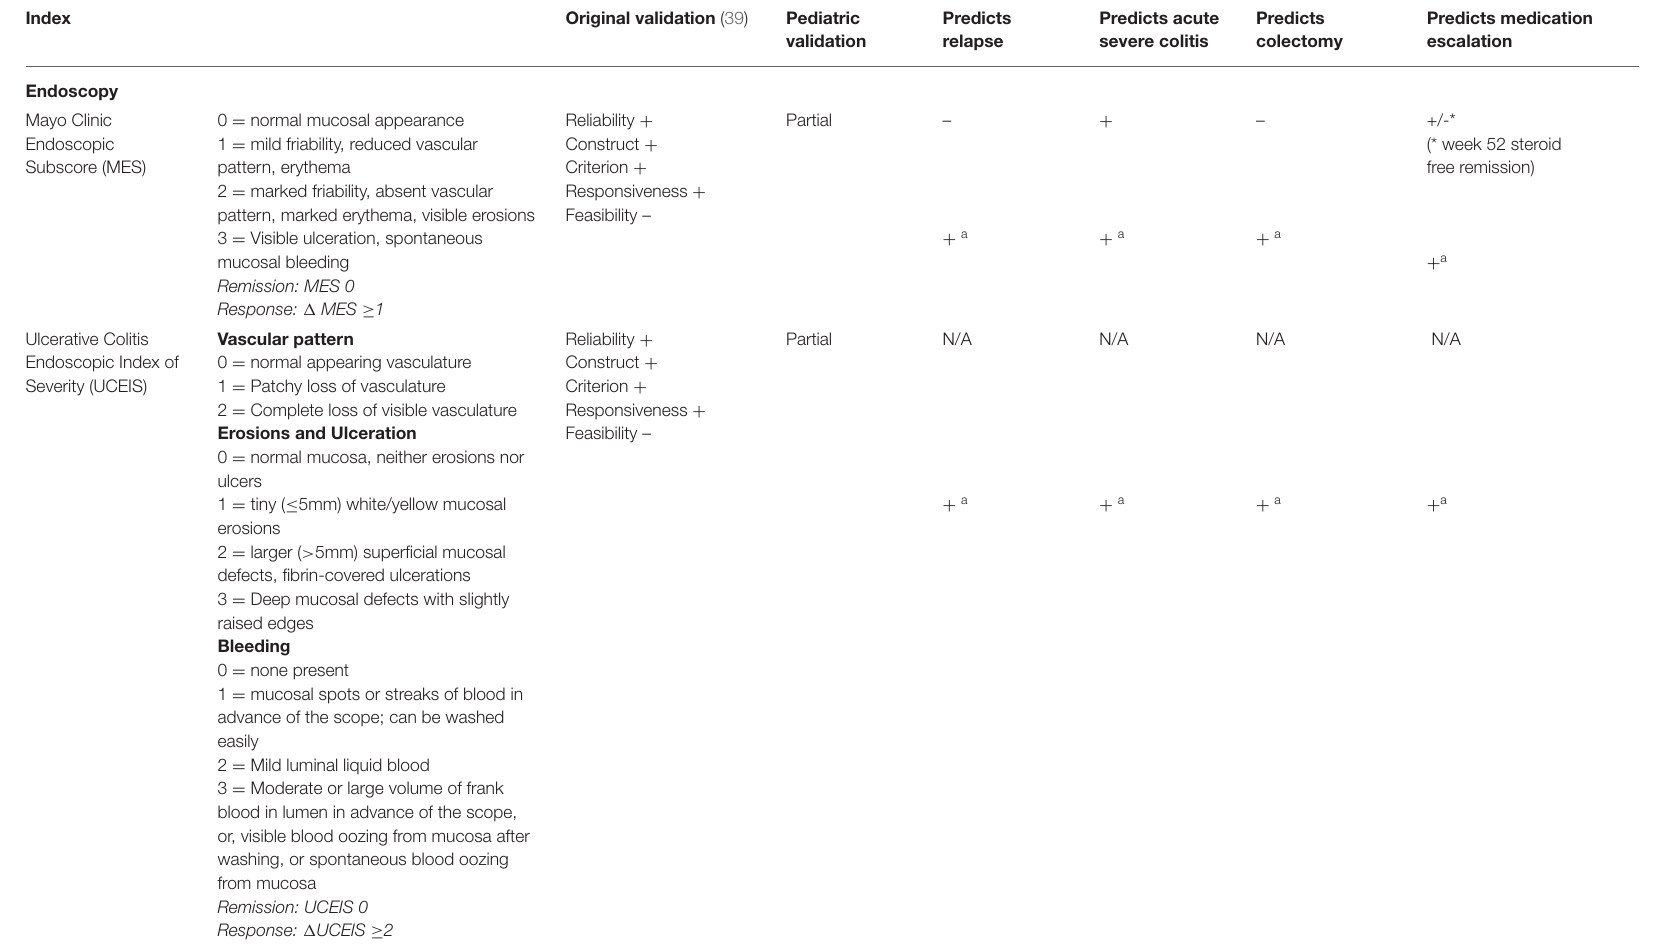
TABLE 2 | Strengths and limitations of endoscopic and histologic scores.